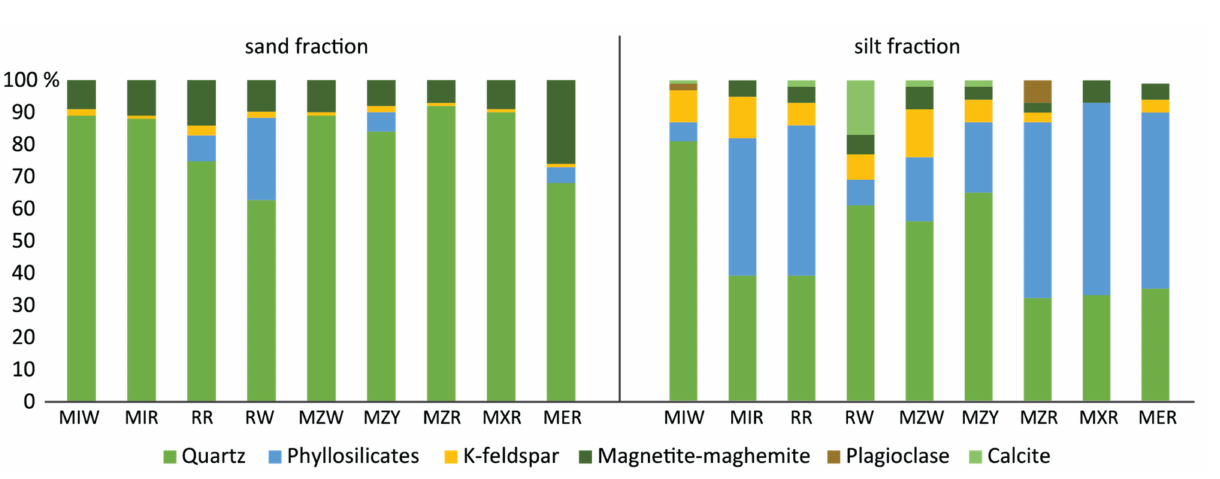
Figure 6. Relative mineralogical composition of sand and silt fractions of studied samples.